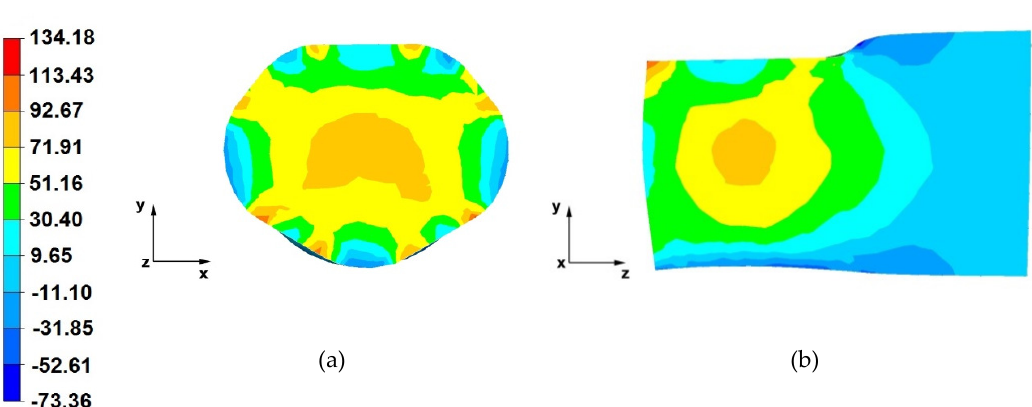
Figure 11. Distribution of the hydrostatic pressure of the AZ 91 alloy forging, deformed in the first pass with 25% reduction in trapezoid and diamond anvils: ( a ) on the cross-section, ( b ) on the longitudinal section.